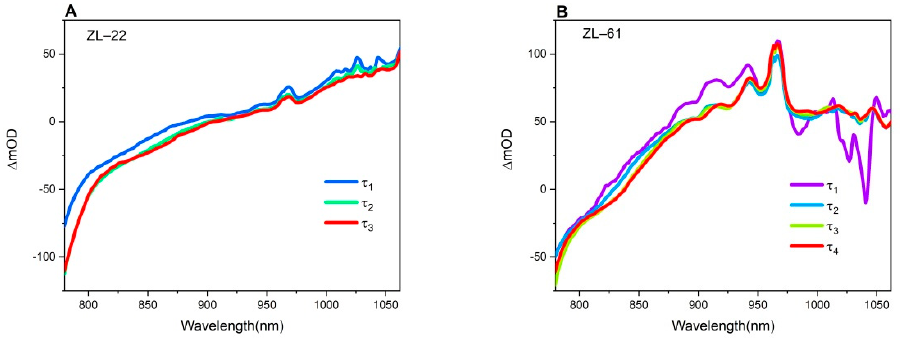
Figure 7. ( A ) Evolution associated difference spectra (EADS) of ZL--22, where 𝜏 (cid:2869) = 4 ps, 𝜏 (cid:2870) = 37 ps, 𝜏 (cid:2871) = 3565 ps; ( B ) EADS of ZL--61, where 𝜏 (cid:2869) = 0.25 ps, 𝜏 (cid:2870) = 3.5 ps, 𝜏 (cid:2871) = 131 ps, 𝜏 (cid:2872) = 3311